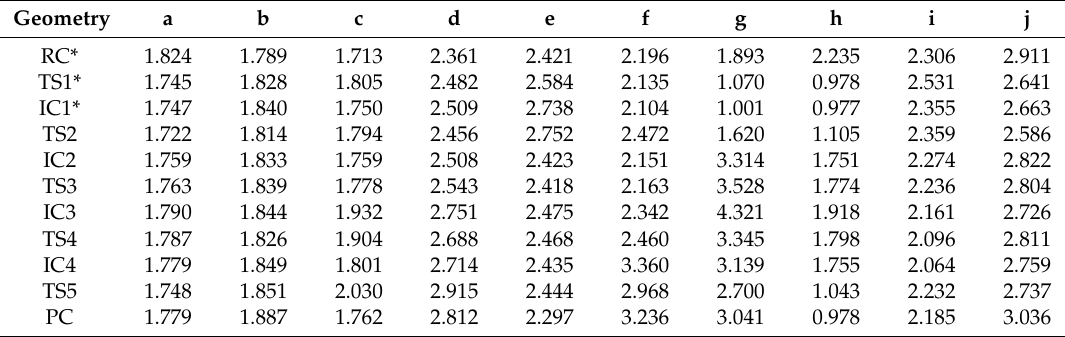
Table 1. Interatomic distances (Å) in the optimized geometries corresponding to the interactions a–j shown in Figure 4. The geometries labeled by an asterisk (*) are those previously reported [67]. Geometry